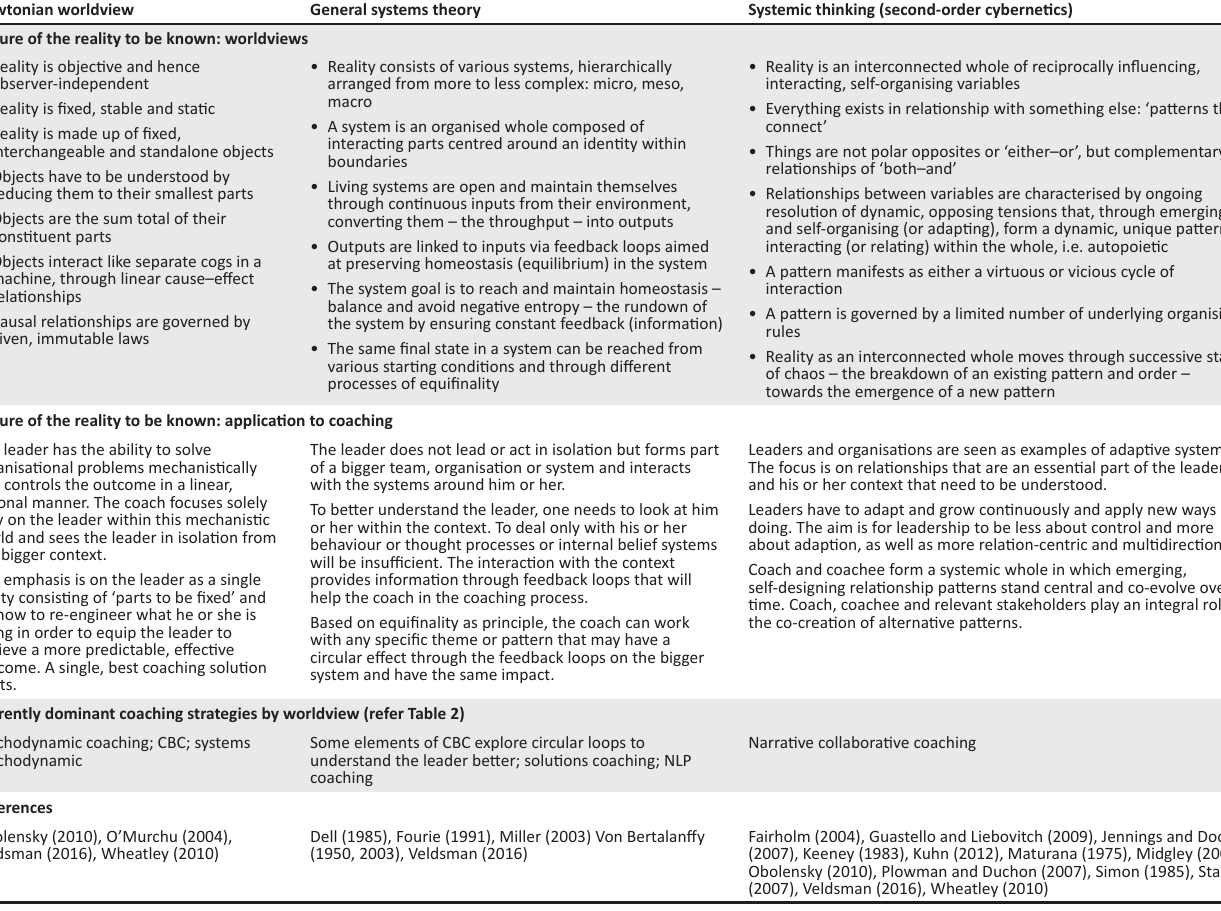
Table 5 addresses the fourth worldview theme: the role of the knower relative to the reality to be known.